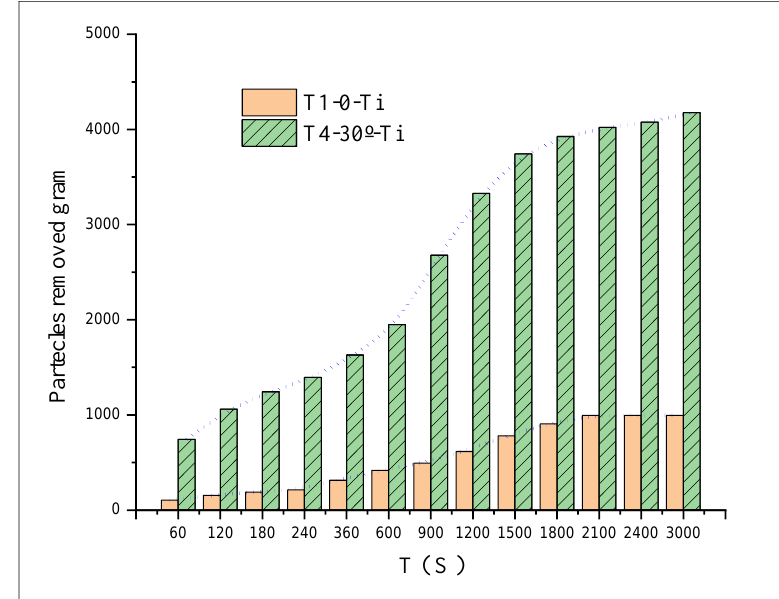
Figure 14. Weight of removed sediments during the test period.